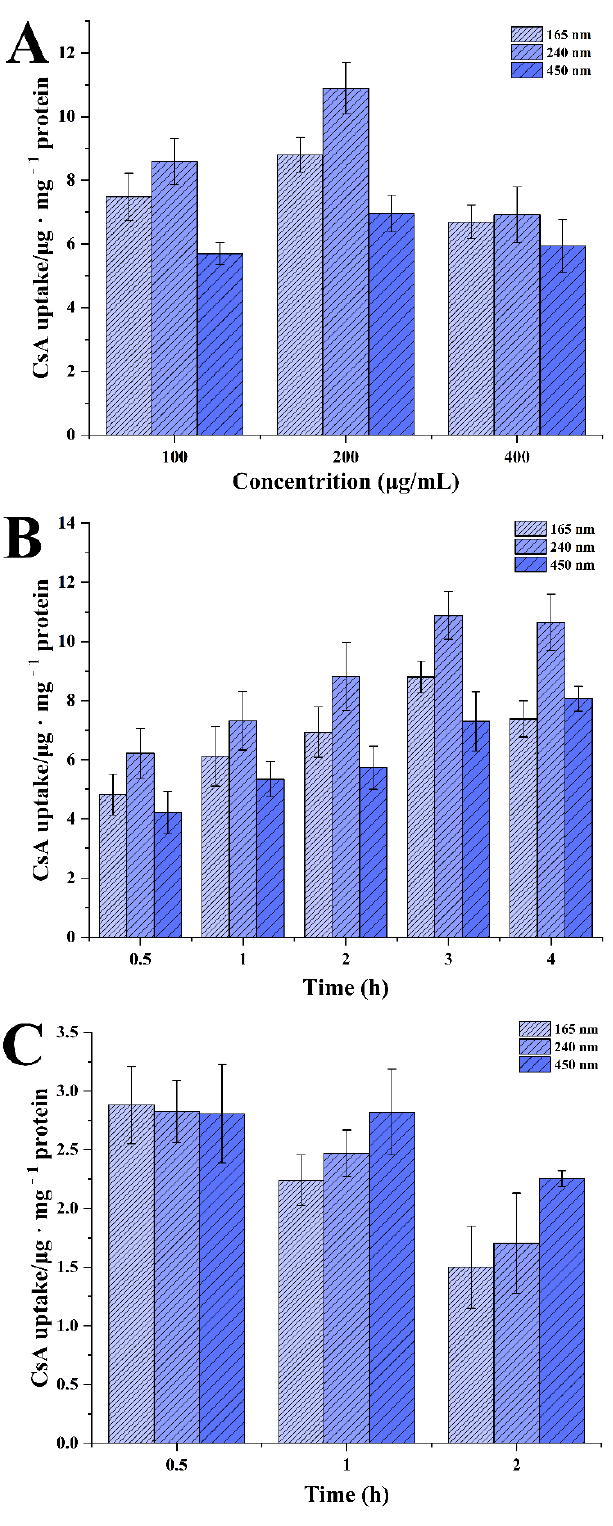
Figure 5. Uptake of CsA-NCs in Caco-2 cells after the incubation of different concentration ( A ) and time ( B ), and additional 2 h incubation with only fresh medium after 3 h of treatment ( C ). (Mean ± SD, n = 6 for each group).